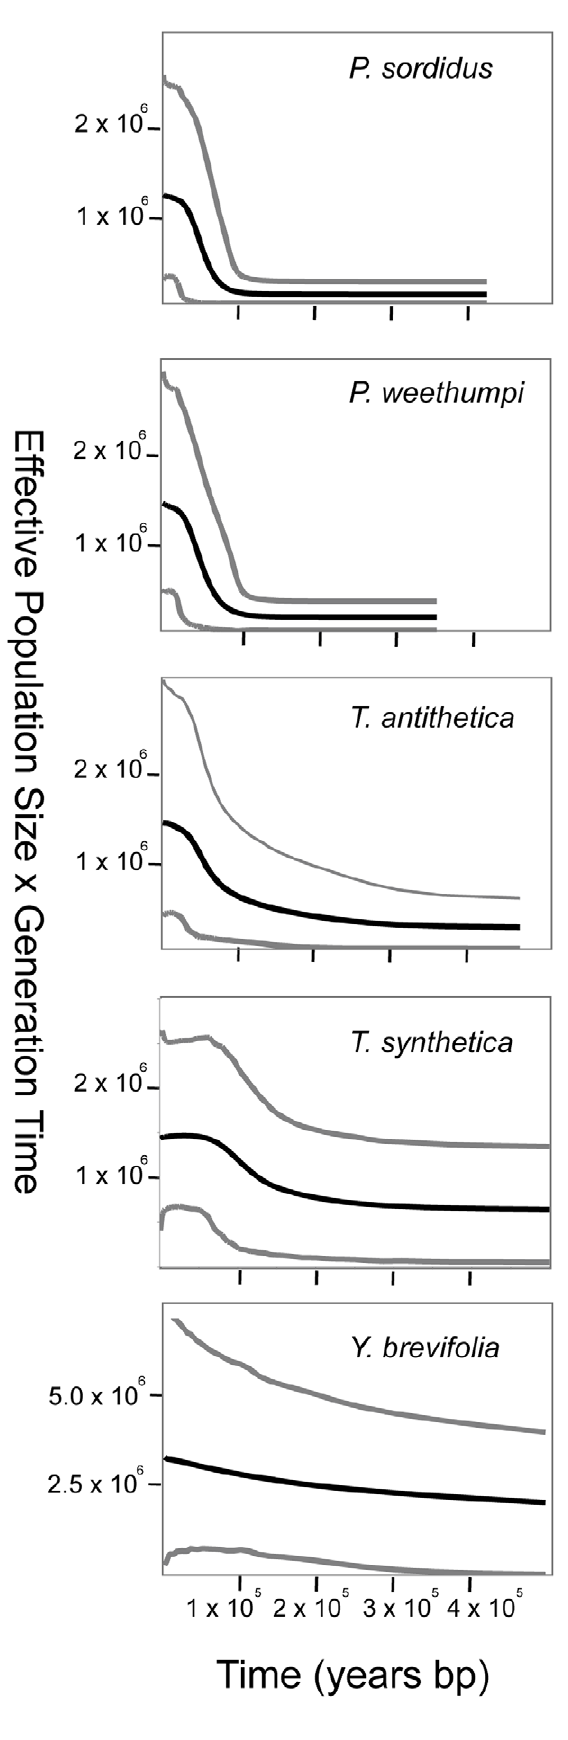
Figure 2. Extended Bayesian Skyline Plots inferred using BEAST v. 1.5.3 from DNA sequence data for Yucca brevifolia and four species of associated yucca moths. The dark lines show the mean of the highest posterior density (HPD) function of population size at each point in time, the grey lines show the upper and lower 95% credibility intervals on the HPD, averaged across multiple independent Markov Chain Monte Carlo simulations. Parameter estimates were . 99% correlated between independent runs. Note that the y-axes are not to